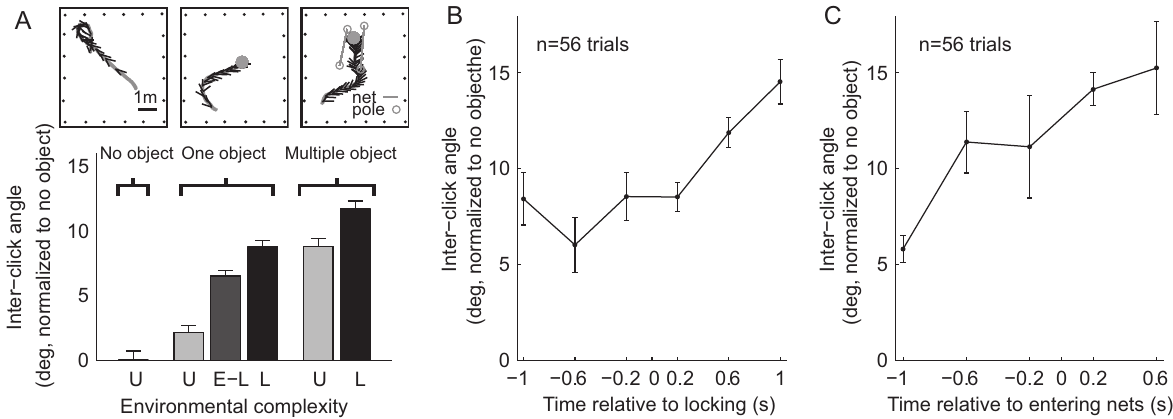
Figure 2. The inter-click angle increases with the increase in environmental complexity. (A) Top, schematic of the three experimental setups. Bottom, inter-click angle in the different experimental conditions. U, unlocked; L, locked; E-L, instances of early-locking prior to the final locking. Note increase in inter-click angle with environmental complexity. (B–C) Increase in inter-click angle along the approach, during multiple- object experiments. (B) In these experiments, the inter-click angle along the approach had a higher value (higher than in the one-object setup) and exhibited a gradual increase after the final locking onto the landing target. (C) When using the bat’s entrance between the nets as an alternative locking criterion, it became evident that most of the increase in inter-click angle has occurred between 1 and 0.5 s before the bats entered in- between the nets. Note different x -axis in (B) and (C). Error bars, mean 6 s.e.m.